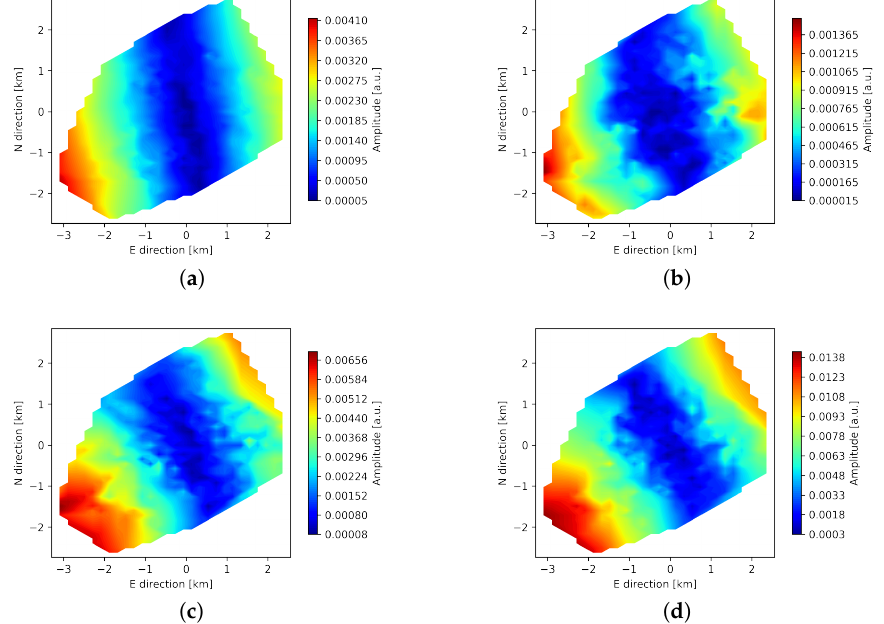
Figure 8. Amplitudes of core stations for the peak 4 of L82655; panels ( a – d ) correspond to 3, 4, 12 and 27 min central periods,